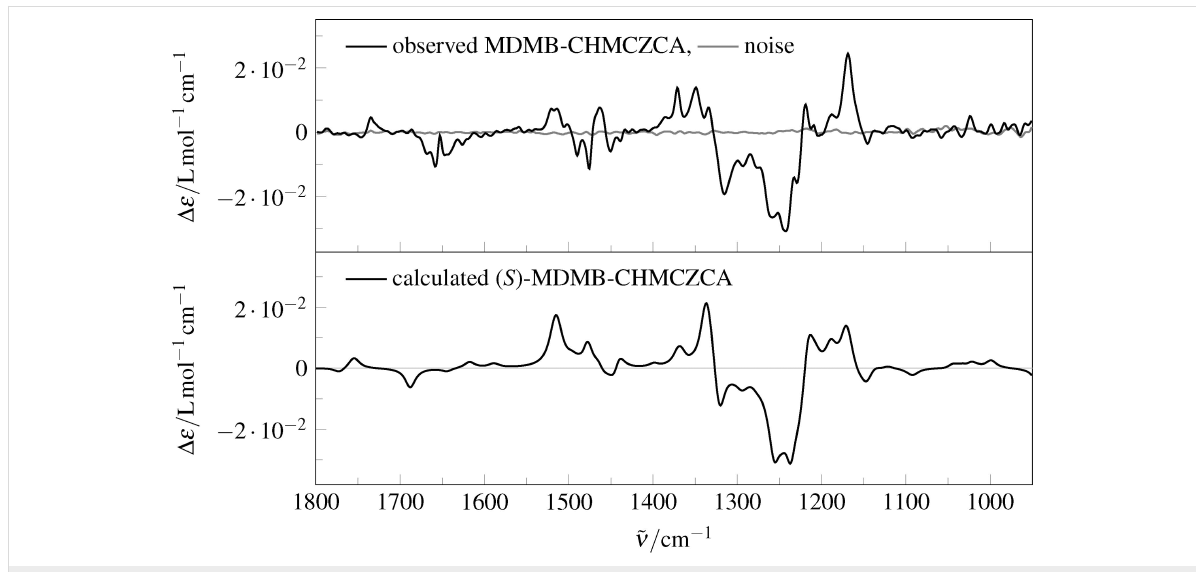
Figure 5: Observed (top) and calculated (bottom) VCD spectra for ( S )- 3 in chloroform, theory level: B3PW91/6-311G**/IEFPCM.